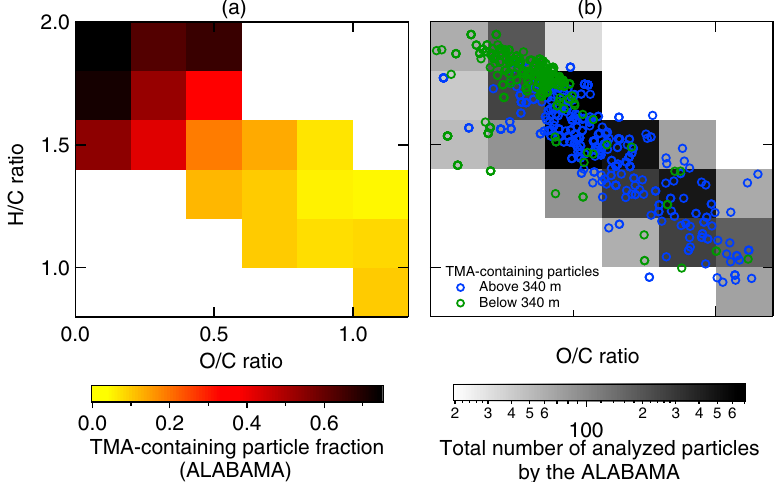
Figure 8. Comparison between the HR-ToF-AMS estimated oxygen-to-carbon (O / C) and hydrogen-to-carbon (H / C) ratios colored by (a) TMA-containing particle number fraction (ALABAMA) and (b) total number of analyzed particles by the ALABAMA (gray to black) as well as the presence of particulate TMA above (blue circles) and below (green circles) 340m (mean upper BL height, Sect. 3.1).